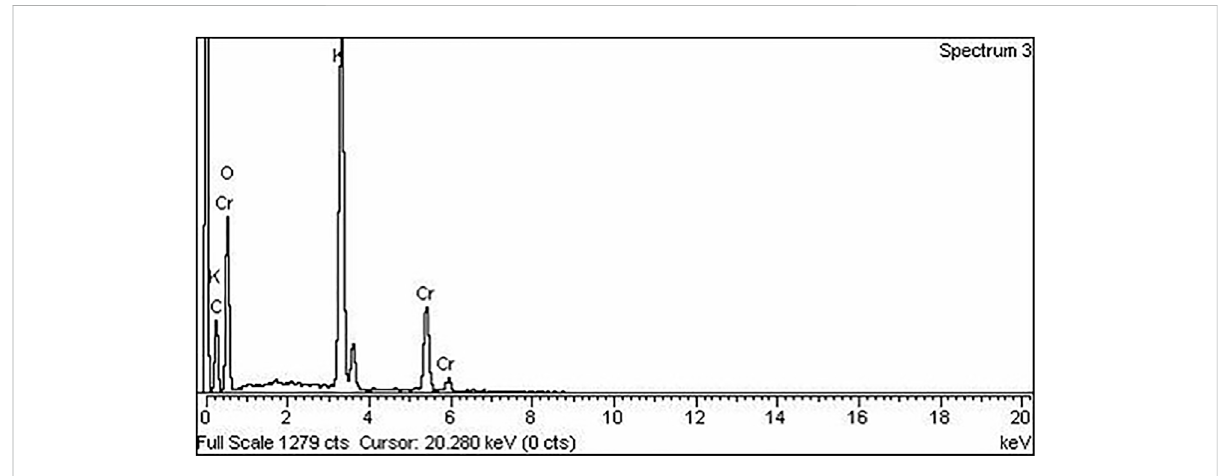
FIGURE 2 EDX spectra of the green synthesized chromium